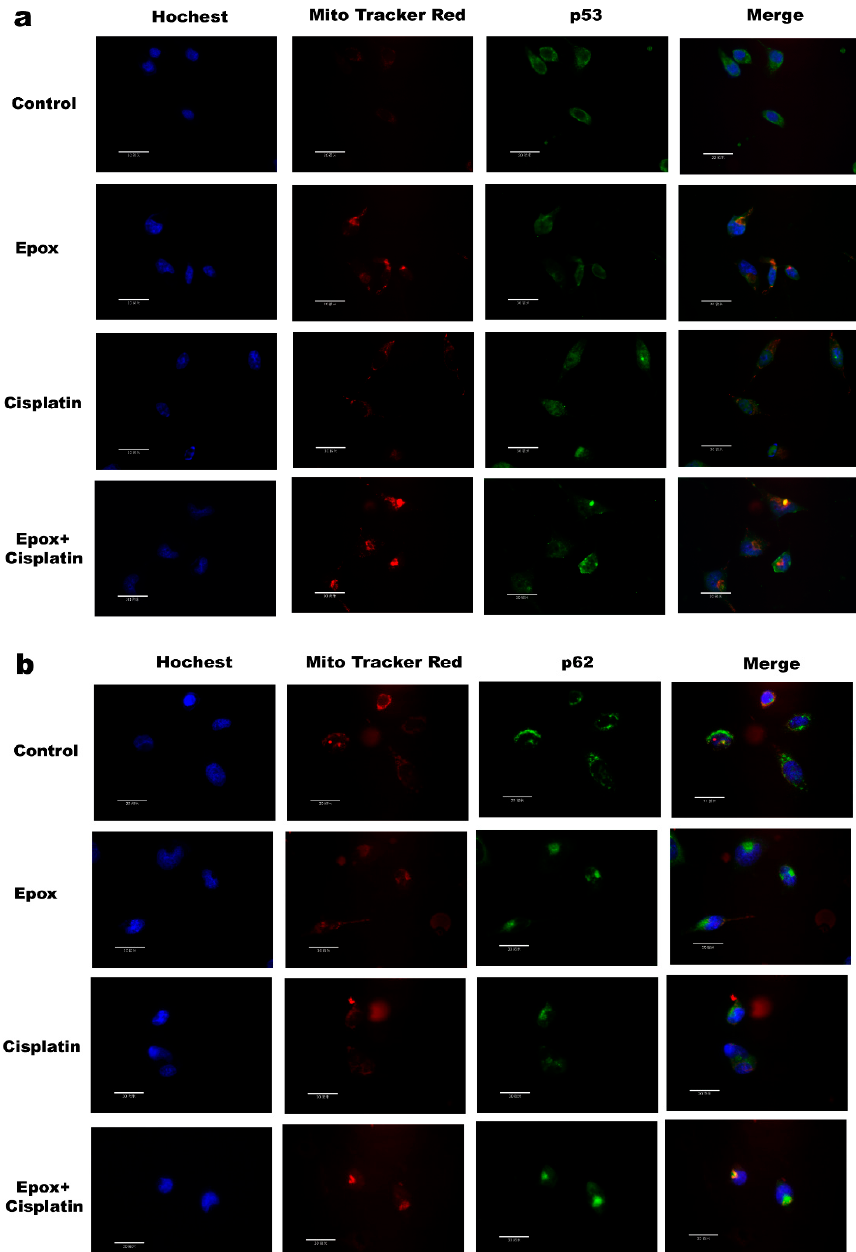
Figure 6. Inhibition of proteasome pathway promoted mitochondrial localization of p53 and p62 in ovarian cancer cells. A2780 cells were treat with cisplatin (2 µg/mL) or epox (100 nM) or both for 12 h. ( a , b ) Immunofluorescence staining for p53, p62 and mitochondria in A2780 cells (bar = 30 µm) . 2.5. UBA Domain Deletion in p62 Inhibited Mitochondrial Localization of p53 p62 is a scaffold protein with multiple functional motifs which plays important roles in both the UPS and autophagy [43]. Wild-type p62 (wt-p62), a UBA domain truncation mutant ( Δ UBA) of p62, and an LIR domain truncation mutant ( Δ LIR) of p62 were transfected into A2780 cells. After treatment with CDDP for 12 h at a dose of 2 µg/mL, mitochondria were isolated to detect the mitochondrial localization of p53. The levels of mitochondrial p53 were decreased in the Δ UBA and Δ LIR groups compared with those of the wt-p62 group (Figure 7a,b). Total mRNA was extracted to examine the effect of the different types of p62 on mtDNA transcription under the same treatments. Compared with